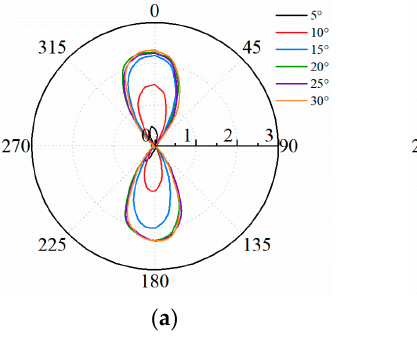
Figure 11. Tensile stress at each section (MPa): ( a ) stress envelopes at Section 1 ‐ 1, ( b ) stress envelopes at Section 6 ‐ 6, and ( c ) curves of the tensile stress of the vault and bottom (black line indicates the points of Section 1 ‐ 1, and the red line indicates the points of Section 6 ‐ 6).